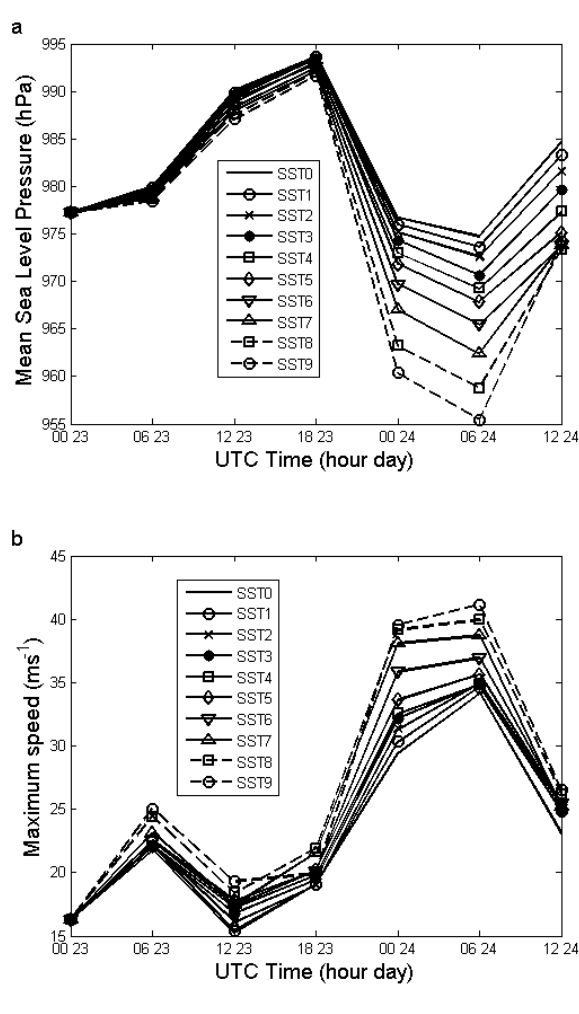
Figure 6. Minimum of MSLP [hPa] (a) and maximum of 10 m wind speed [ m s -1 ] (b) over the Bay of Biscay as a function of SST anomaly.